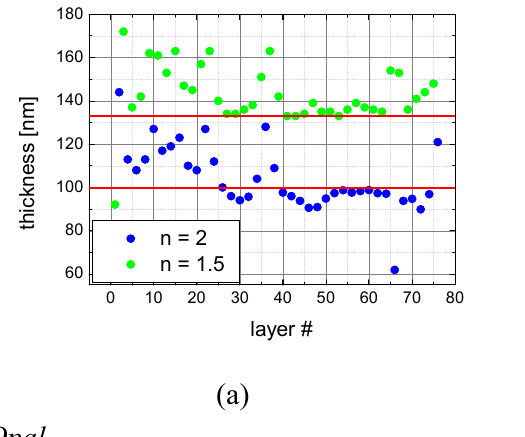
Figure 3. (a) Distribution of thicknesses for an optimized edge filter and (b) reflection characteristic. The filter was optimized theoretically using an evolutionary algorithm and starting with a Bragg-stack. In the thickness distribution, the red lines give the thicknesses that a Bragg-stack with comparable characteristics would have. The thicknesses of the single layers of the edge filter are distributed around these lines. For the edge filter, therefore, some periodicity remains. The filter was optimized to transmit between λ = 400 nm and λ = 700 nm and to reflect between λ = 700 nm and λ = 1,000 nm. The number of layers used was preset to